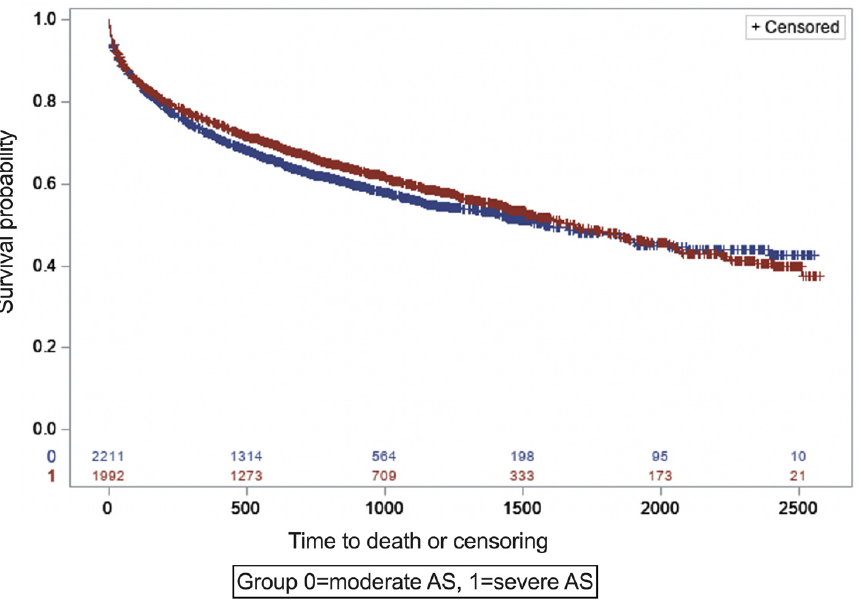
Figure 2. Mortality of patients with moderate and severe AS. Unadjusted mortality using Kaplan– Meier curves for 2 groups (moderate AS (blue curve) vs. severe AS (red curve)).